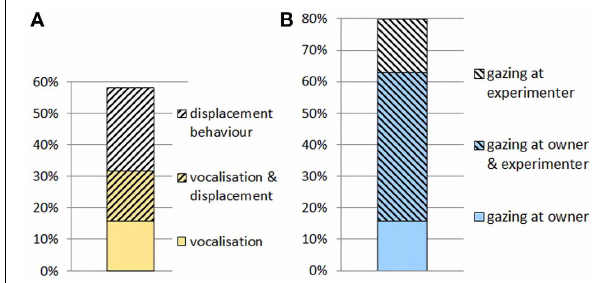
FIGURE 5 | (A) Proportion of dogs that vocalized, exhibited displacement behaviors or did both when the experimenter did not hand over the object. (B) Proportion of dogs that gazed at the owner, the experimenter or at both of them when the experimenter did not hand over the object.